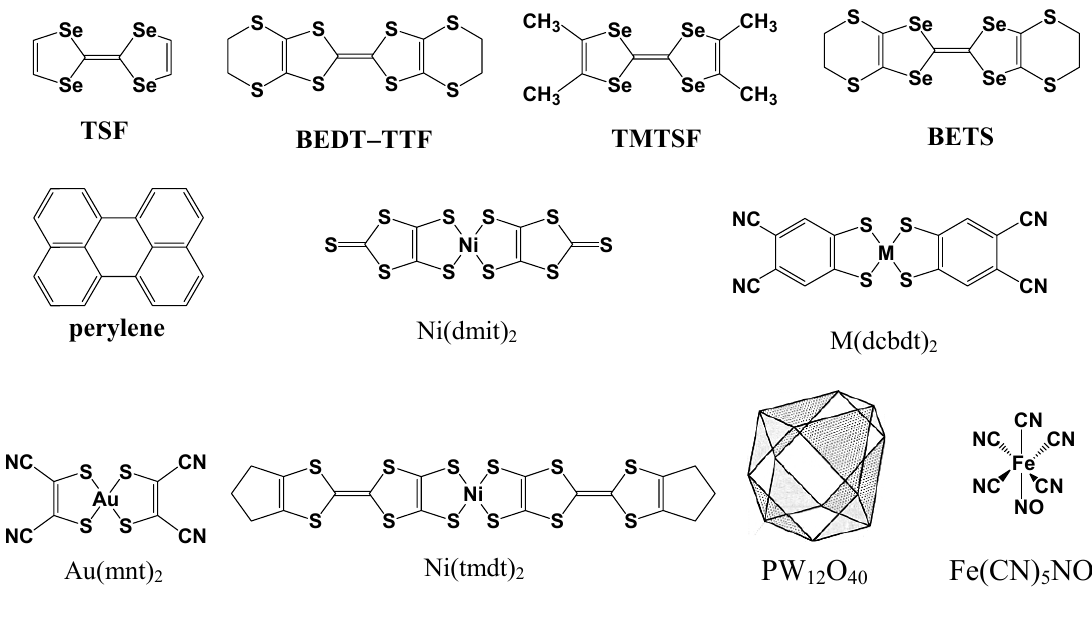
Figure 10. The chemical structures of donor molecules ( TSF , BEDT–TTF , TMTSF , BETS , and perylene ) and anions (Ni(dmit) 2– , M(dcbdt) 2– , Au(mnt) 2– , Ni(tmdt) 2–